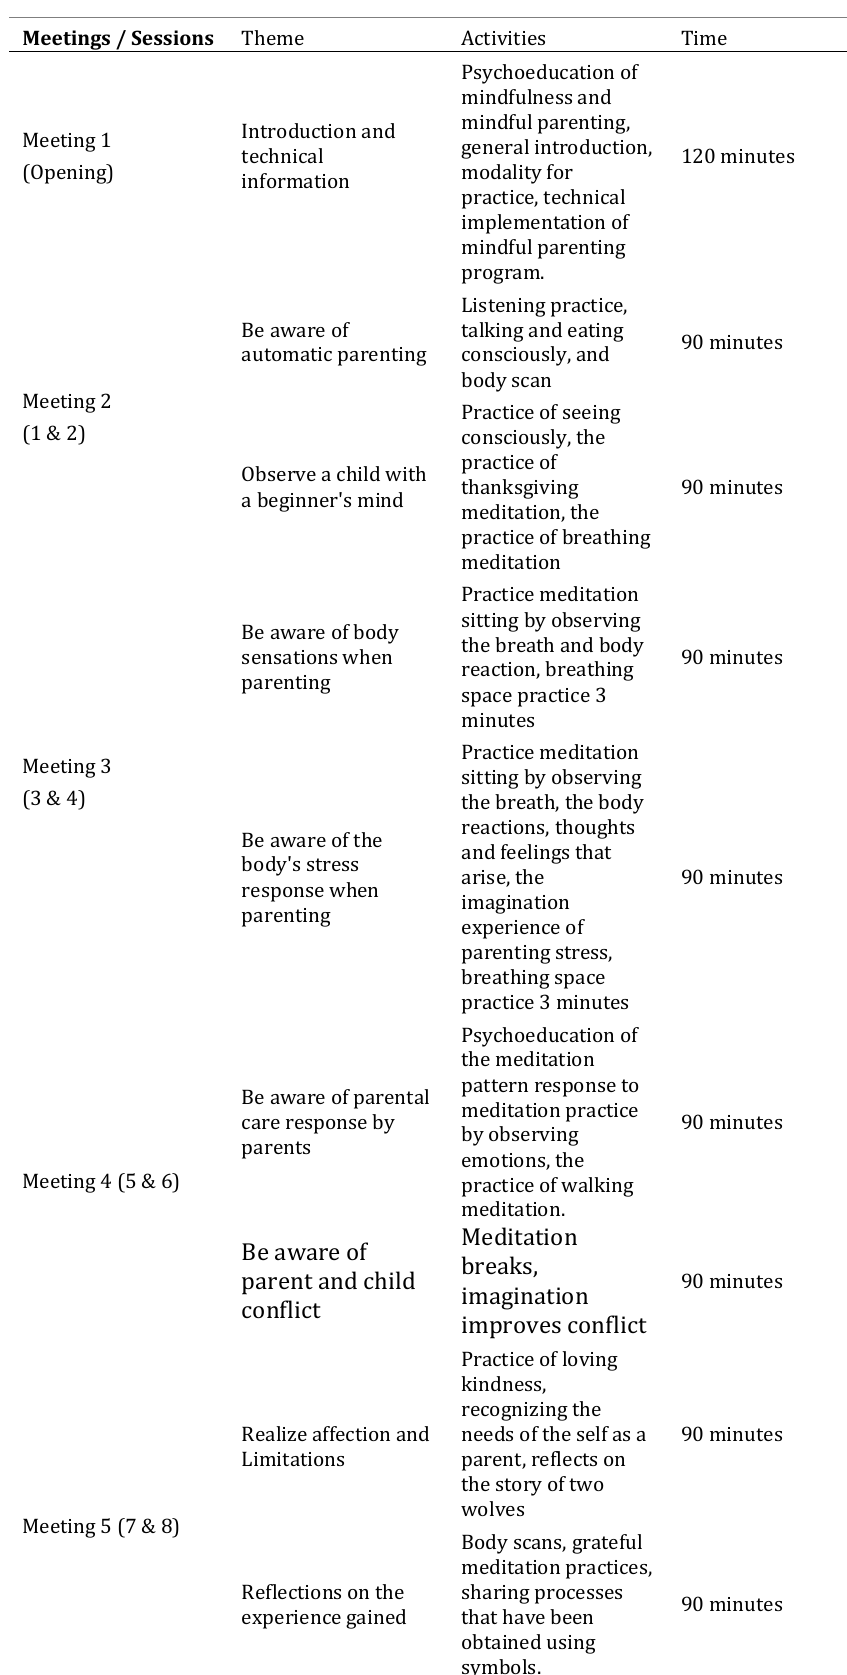
Table 2 Mindful parenting module